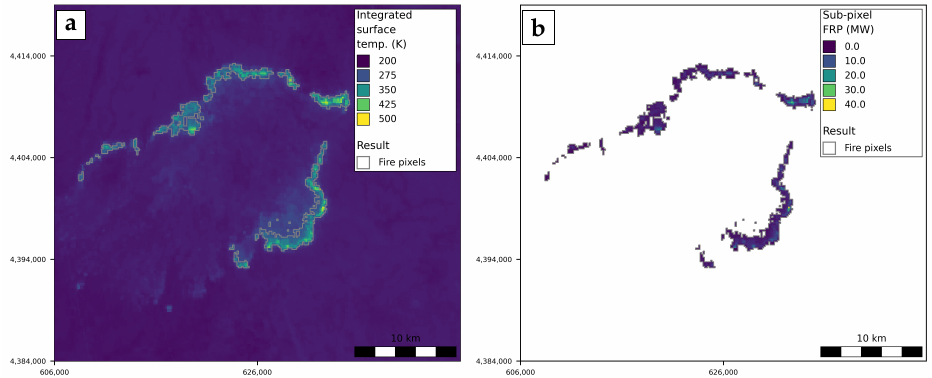
Figure 2. Results of atmospheric correction and FRP derivation for a TET-1 overpass covering the fire event in California/US, 10 November 2018, at 19:25 UTC. ( a ) shows the atmospherically corrected MWIR band, together with a gray boundary indicating the derived fire pixels. Sub-figure ( b ) shows the same fire pixels with their subsequently derived FRP